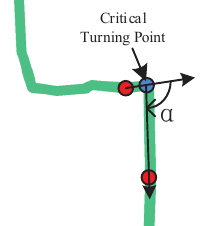
Figure 5. Direction difference (represented by α ) of two neighboring road segments. The blue circle represents a critical turning point; the two red circles represent two adjacent points of the critical turning